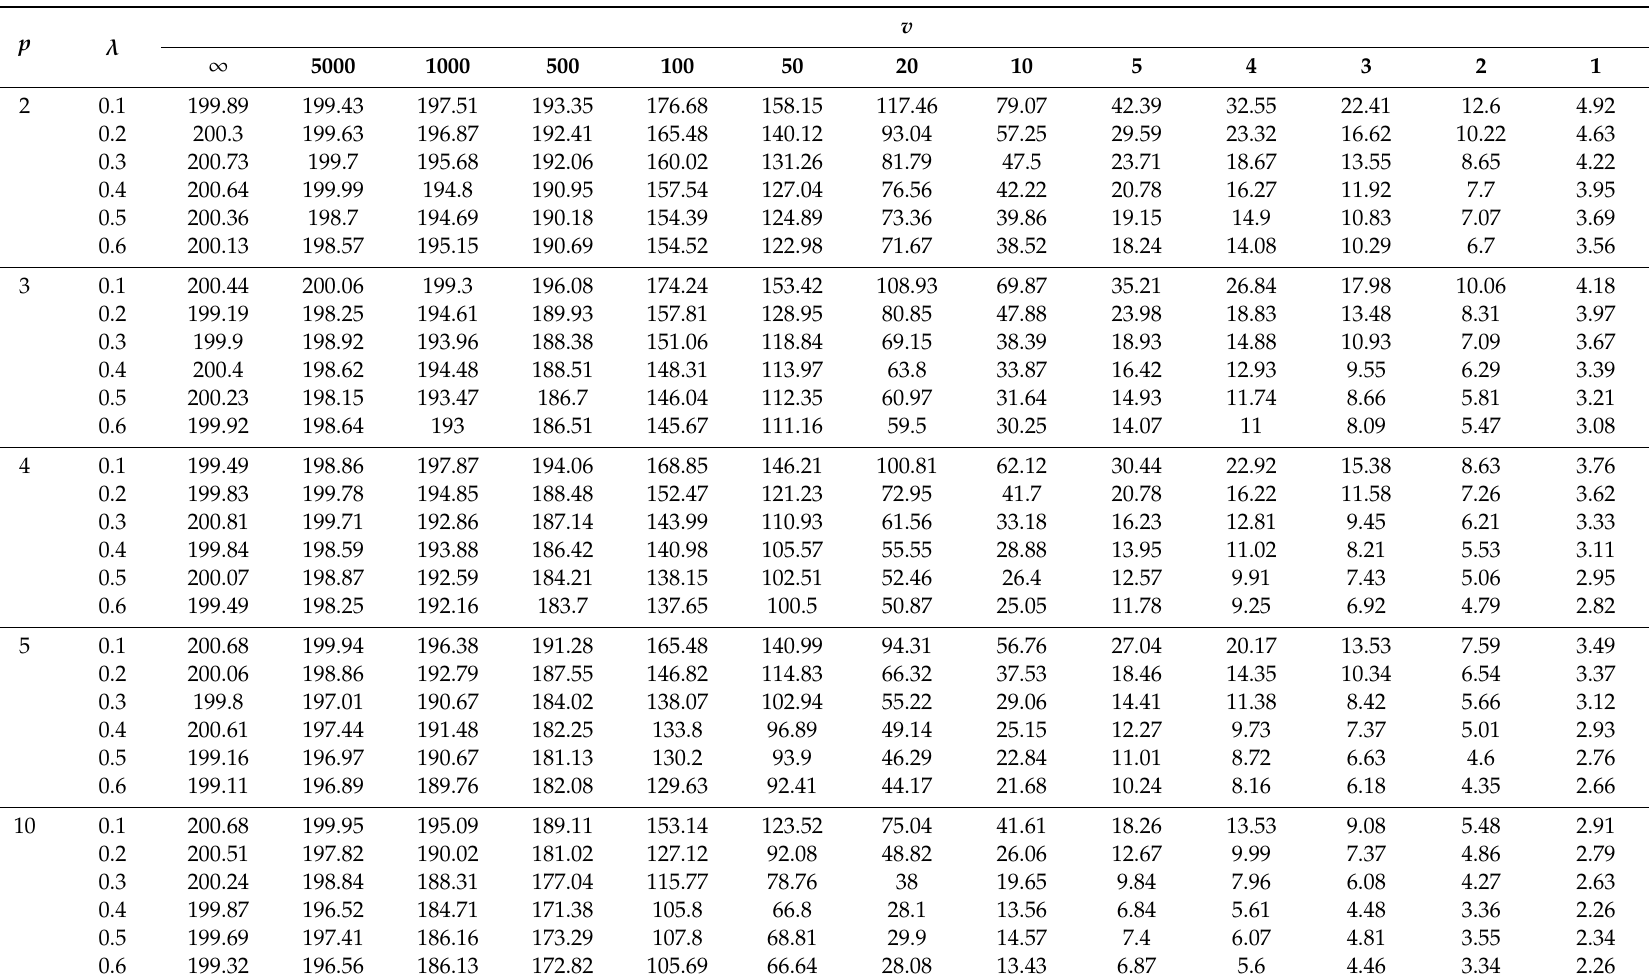
Table 8. ARL values of MHWMA chart for multivariate